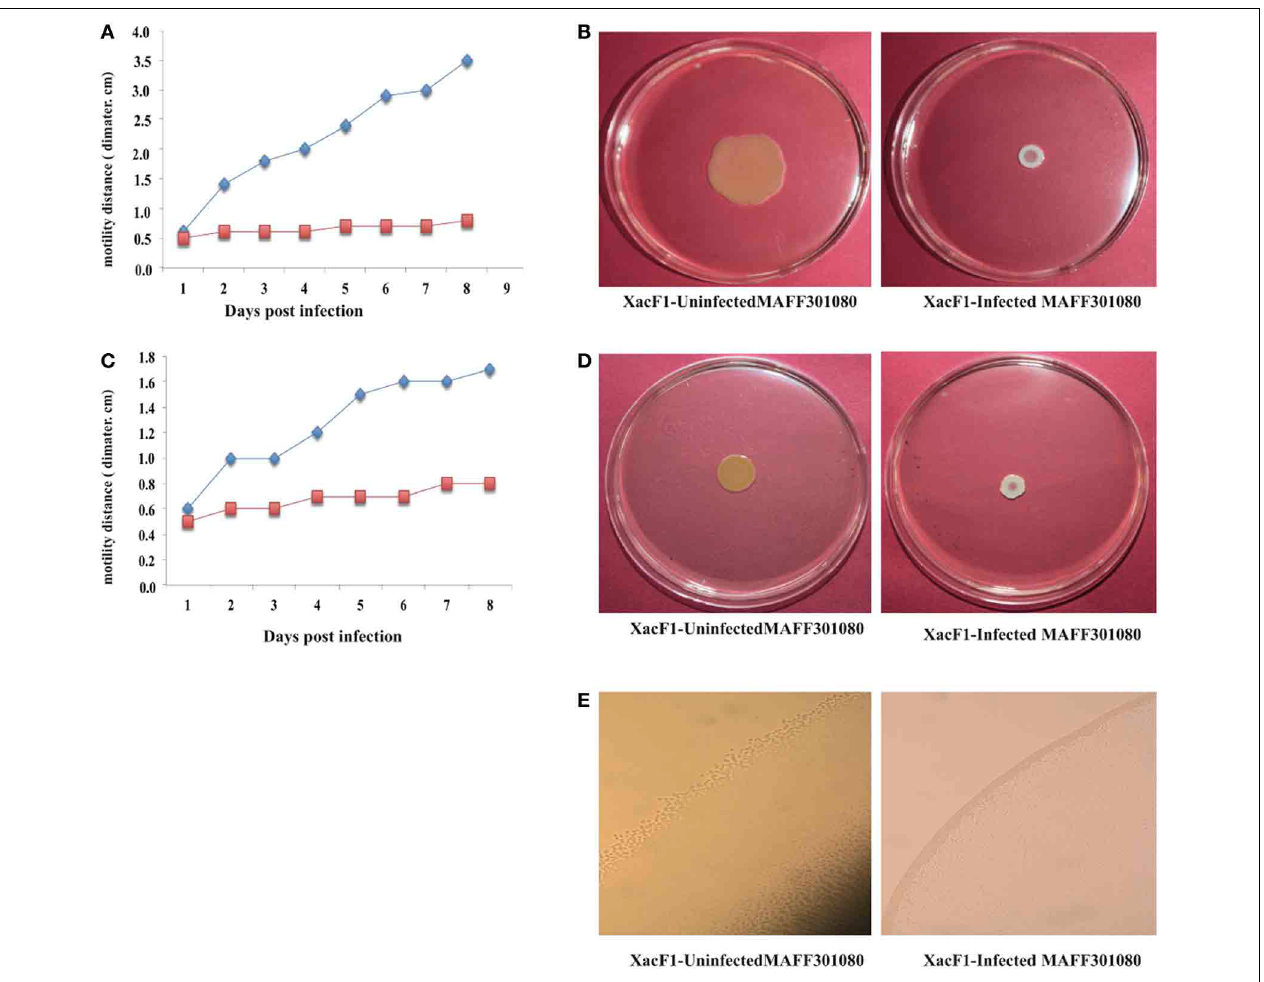
FIGURE 5 | Impact of XacF1 infection on the motility of Xac MAFF301080 cells. Two microliters of bacterial solution [10 8 colony forming units (CFU)/mL] were inoculated in the swimming assay [0.3% (w/v) agar] (A,B) , swarming assay [0.7% (w/v) agar] (C,D) , and twitching motility assay